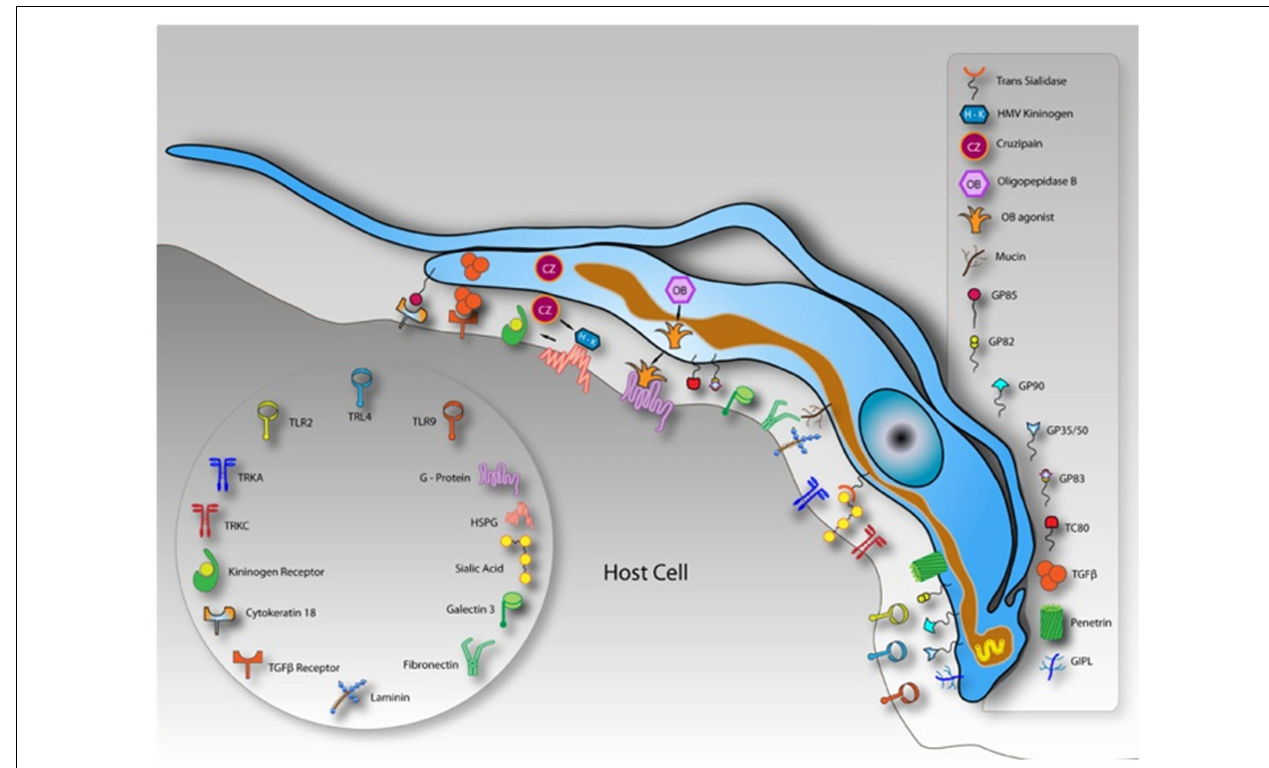
FIGURE 2 | Schematic model demonstrating molecules involved on parasite-host cell interaction process and exposed on the surface of a hypothetical host cell and in trypomastigotes of Trypanosoma cruzi . After Ref. (3).